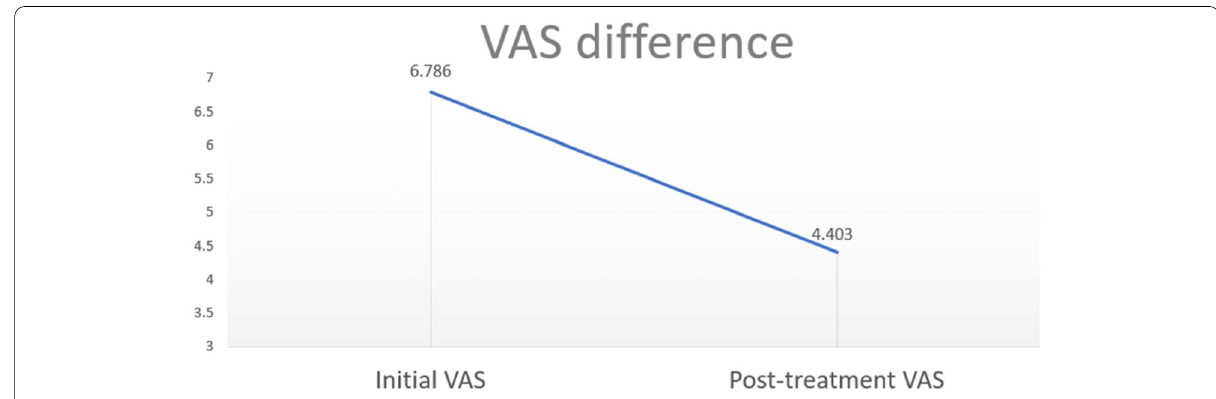
Fig. 5 After the treatment, the VAS value of all 154 patients